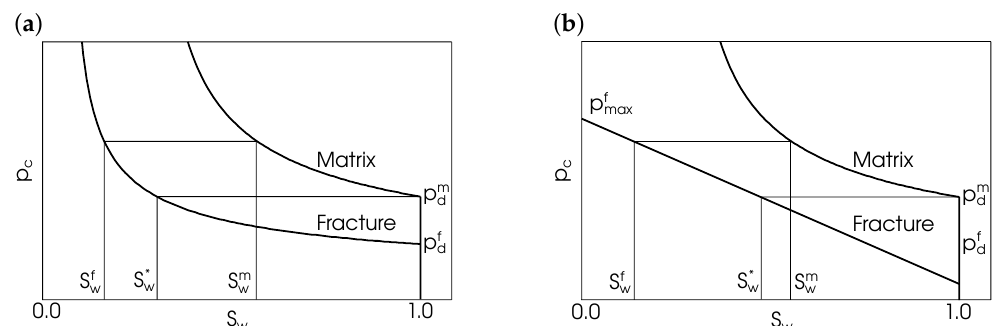
Figure 2. The extended pressure condition corresponding to different fracture capillary pressure curves: ( a ) the Brooks-Corey type and ( b ) the linear type, Romm